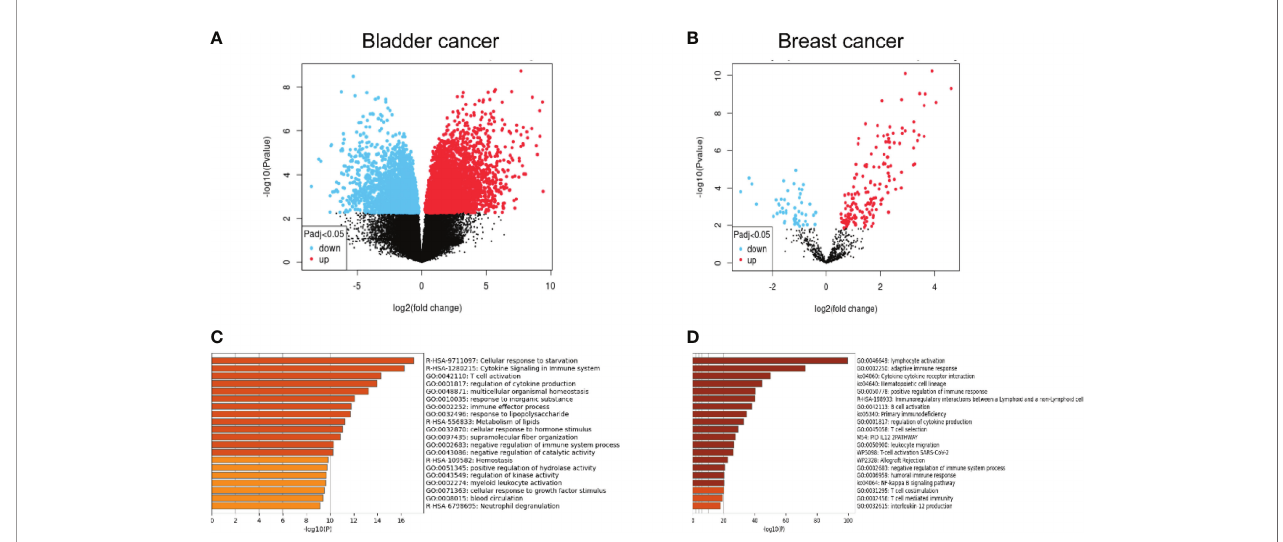
FIGURE 1 | (A, B) Comparative analysis from the microarray data extracted from the GEO database illustrating the signi fi cantly upregulated and downregulated genes between lymph node metastases and primary tumor. (C, D) Gene-enrichment analysis showing the predicted enriched pathways mediated by the signi fi cantly upregulated genes in the lymph node metastases compared with the primary tumor using Metascape